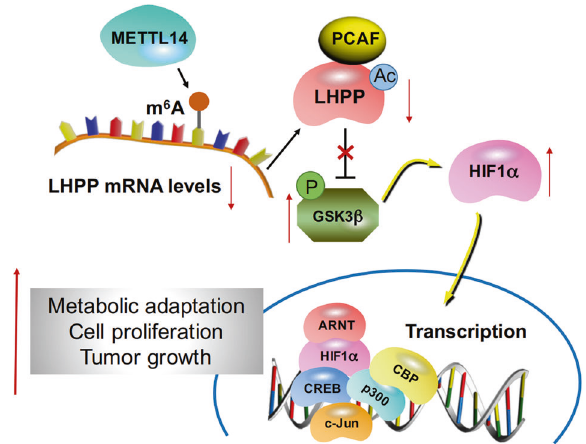
Fig. 7 Proposed mechanism scheme of LHPP in GC. The m6A modi fi cation of LHPP mRNA by METTL14 represses its expression; LHPP inhibits the phosphorylation of GSK3b through acetylation and mediates HIF1A to inhibit glycolysis, proliferation, invasion and metastasis of gastric cancer